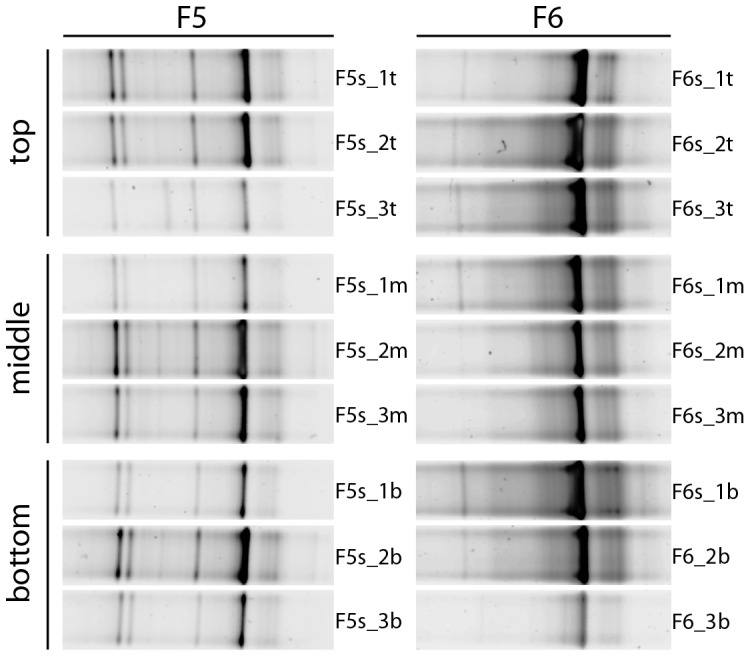
Denaturing gradient gel electrophoresis of thaumarchaeal 16S rRNA genes from spatially distinct locations within freshwater biofilters F5 and F6 during spatial test.For detailed characteristics of the samples, refer to Table 1.